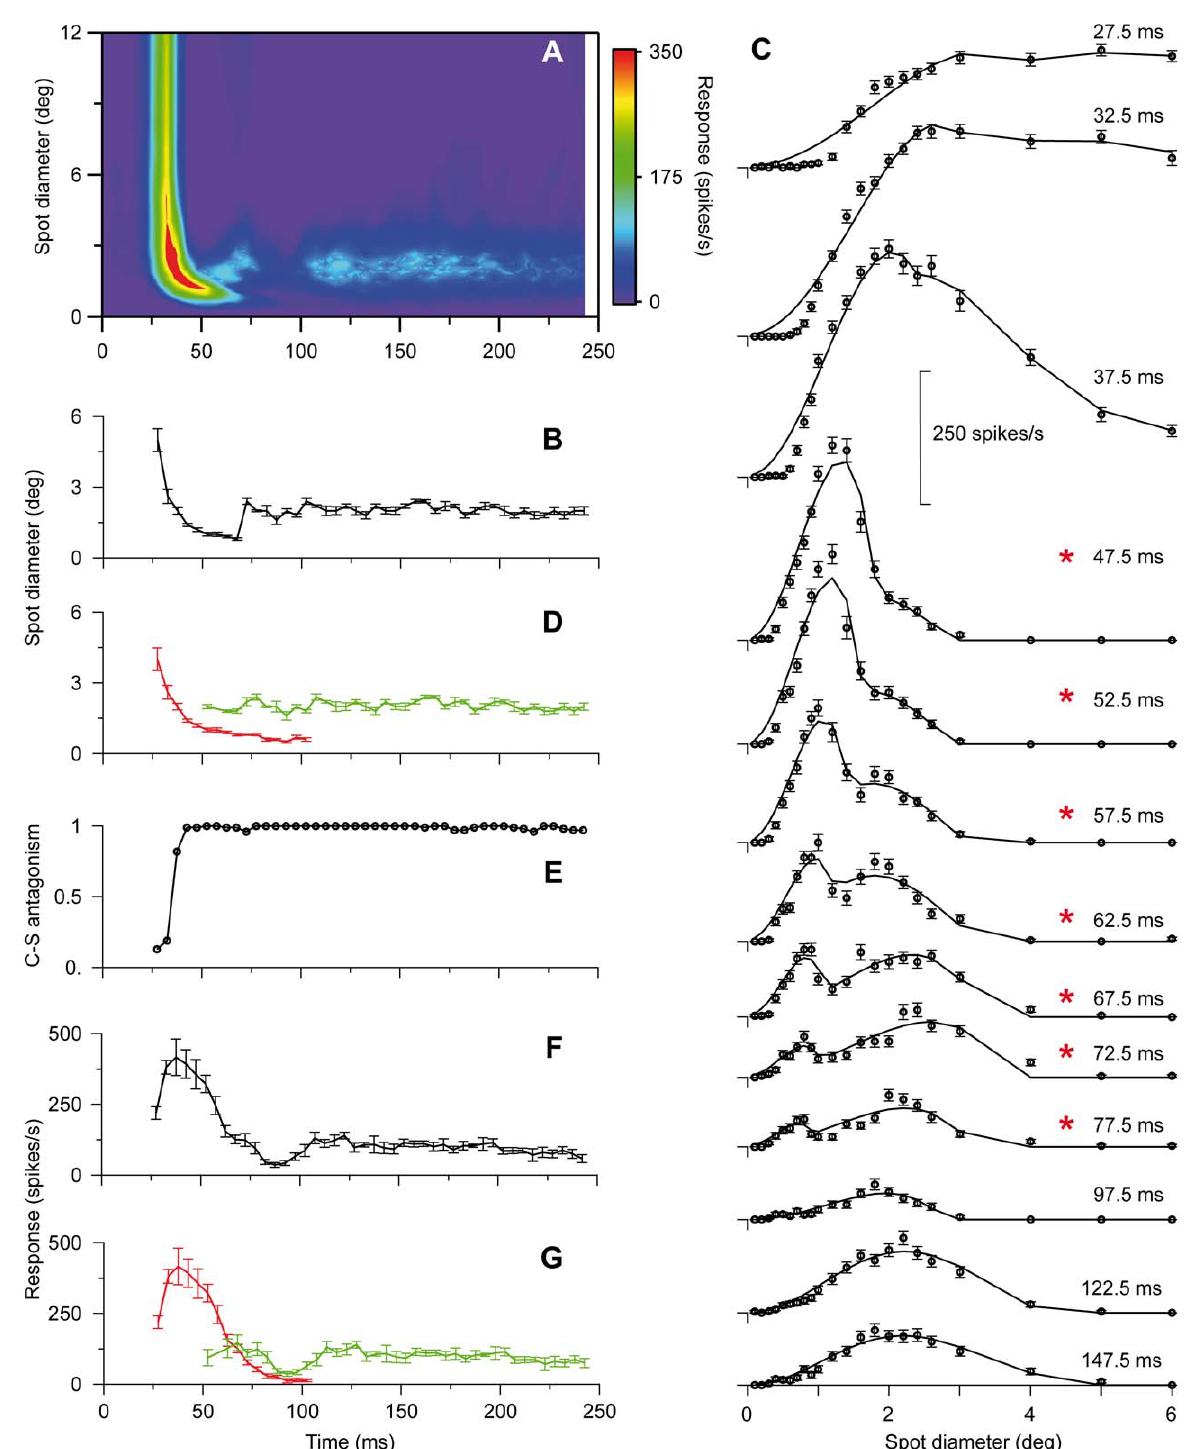
Figure 3. RF dynamics of an off-center Y-neuron. Similar plots as for the Y-neuron in Fig. 1. Number of presentations of each spot 115.